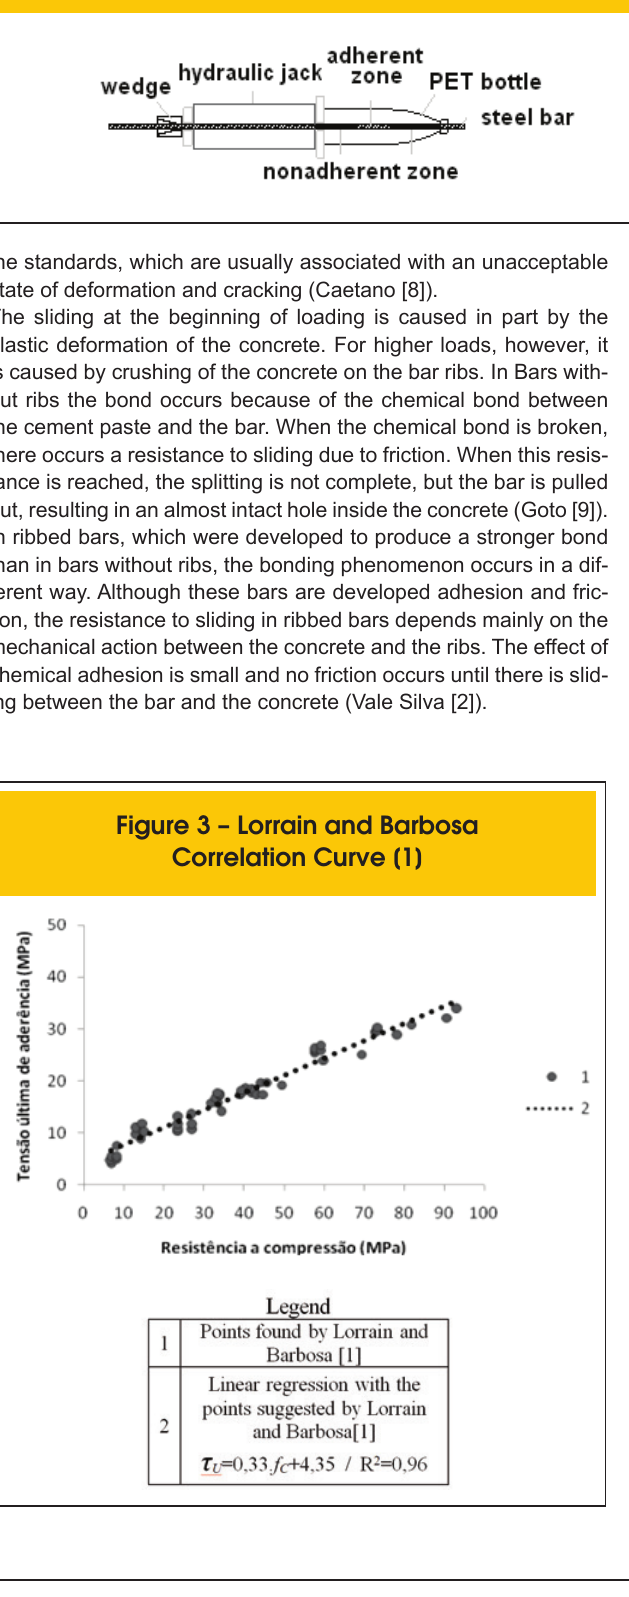
Figure 2 – Schematic of APULOT test (Vale Silva [2])